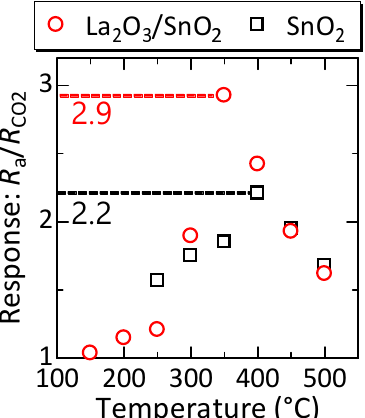
Figure 6. Temperature dependence of the CO 2 response of the sensors. The sensitivities of both SnO 2 and La 2 O 3 /SnO 2 elements are plotted. SnO 2 showed the highest response of 2.2 near 400 ◦ C, whereas La 2 O 3 /SnO 2 showed a higher response of 2.9 than SnO 2 near 350 ◦